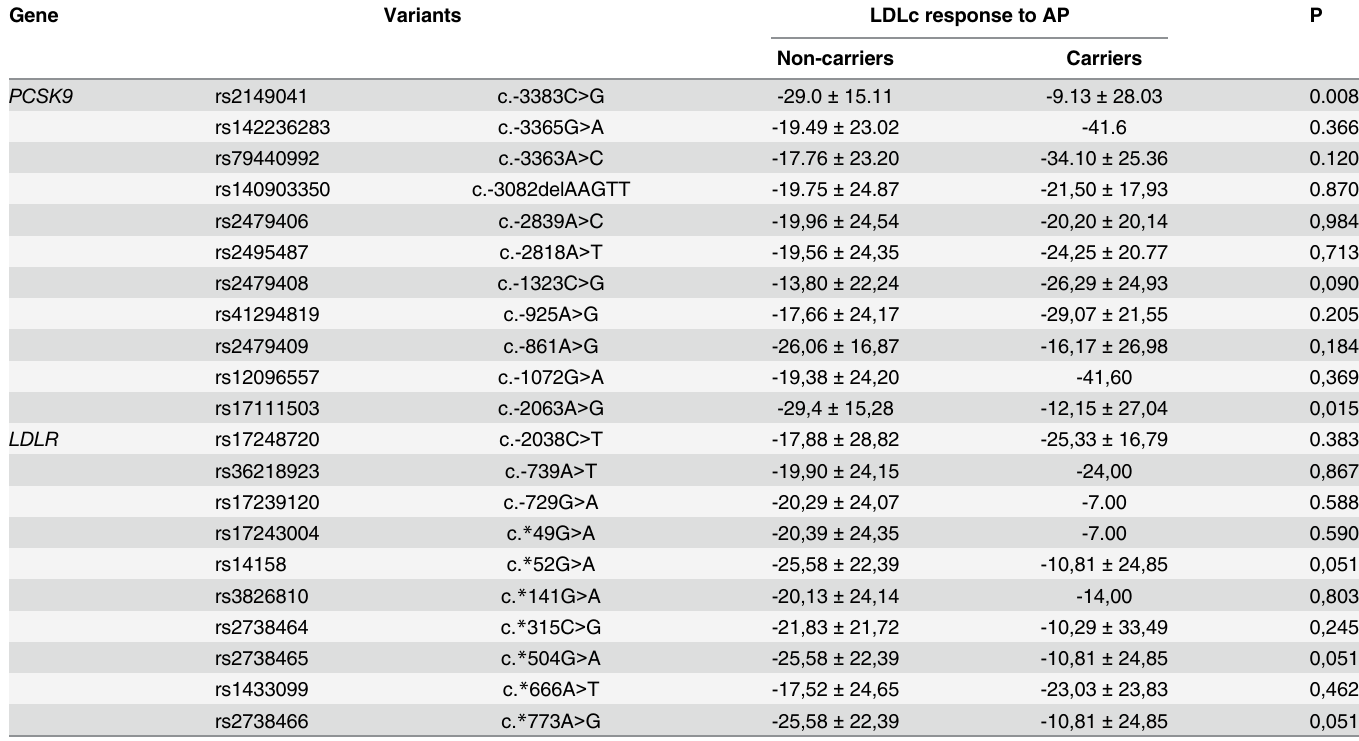
Table 1. LDL cholesterol response to Armolipid Plus 1 in study subjects classified according to be carriers of the minor allele of the PCSK9 and LDLR Variants.